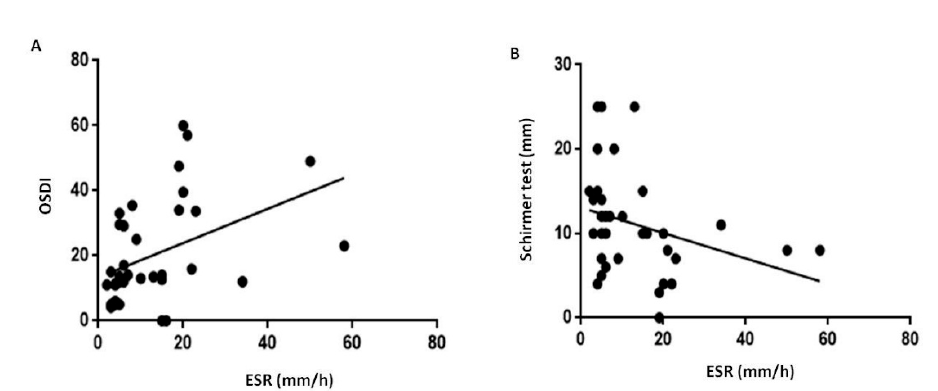
Figure 1. Impairment in quality and quantity of the tear film in patients with psoriatic arthritis sine psoriasis. Abbreviation: OSDI, Ocular Surface Disease Index; ESR, Erythrocyte sedimentation rate. In psoriatic arthritis patients, ESR resulted positively related with OSDI questionnaire (panel ( A ), r = 0.6, p < 0.001) and negatively related with Schirmer test (panel ( B ), r = − 0.43, p = 0.007). The significance of any correlation was determined by Pearson correlation test or Spearman’s rank correlation coefficient where appropriate. P values < 0.05 were considered significant.